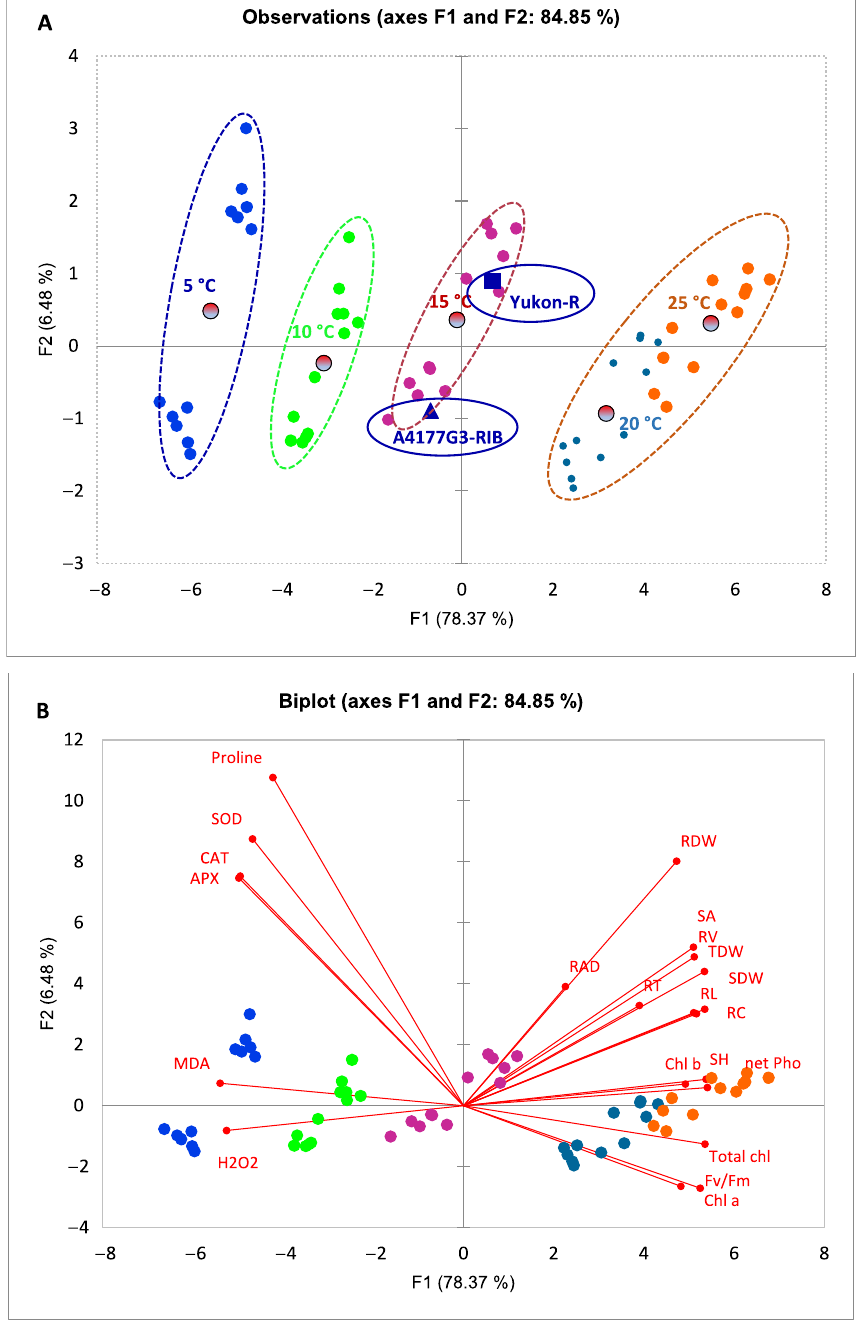
Figure 5. Observation plot showing separation of different temperature and silage corn genotypes in different quadrants ( A ). PCA biplot showing the association of morphological, physiological, and biochemical attributes of silage corn genotypes grown at different temperatures ( B ). APX: ascorbate peroxidase; CAT: catalase; SOD: superoxide dismutase; Chl a : chlorophyll a ; Chl b : chlorophyll b ; H 2 O 2 : hydrogen peroxide; MDA: malondialdehyde; RDW: root dry weight; RL: root length; RSA: root surface area; RV: root volume; SDW: shoot dry weight; SH: seedling height; total Chl: total chlorophyll.